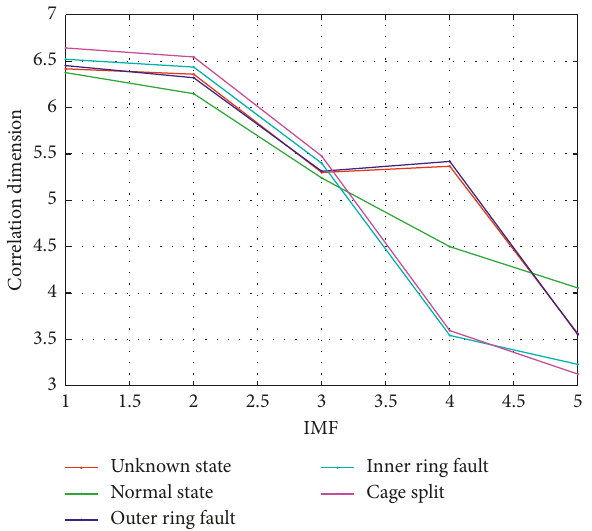
Figure 8: Correlation dimension